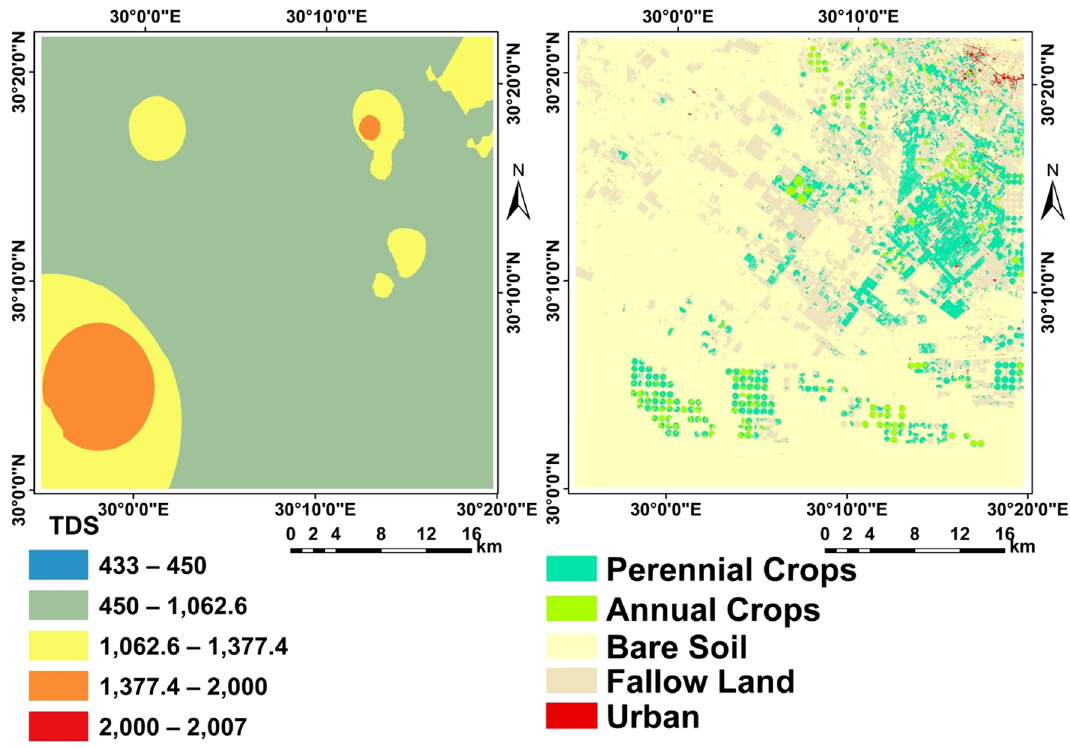
Figure 5. Spatial variation of ground water TDS and LULC.